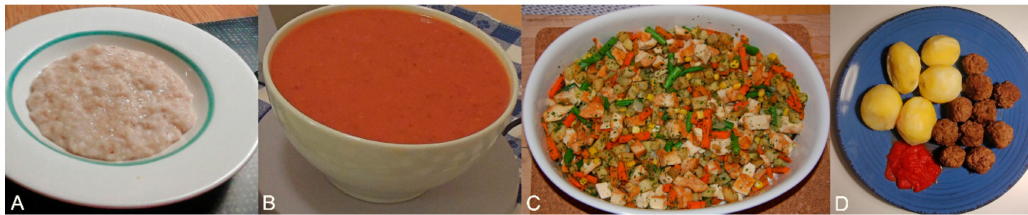
Figure 2. The foods served in the meals analyzed here: ( A ) porridge (served in the TD), ( B ) soup (served in TD), ( C ) hash meal (served in TD and BD), ( D ) meatballs and potatoes (served in